Question: In one sentence, what is this figure communicating?
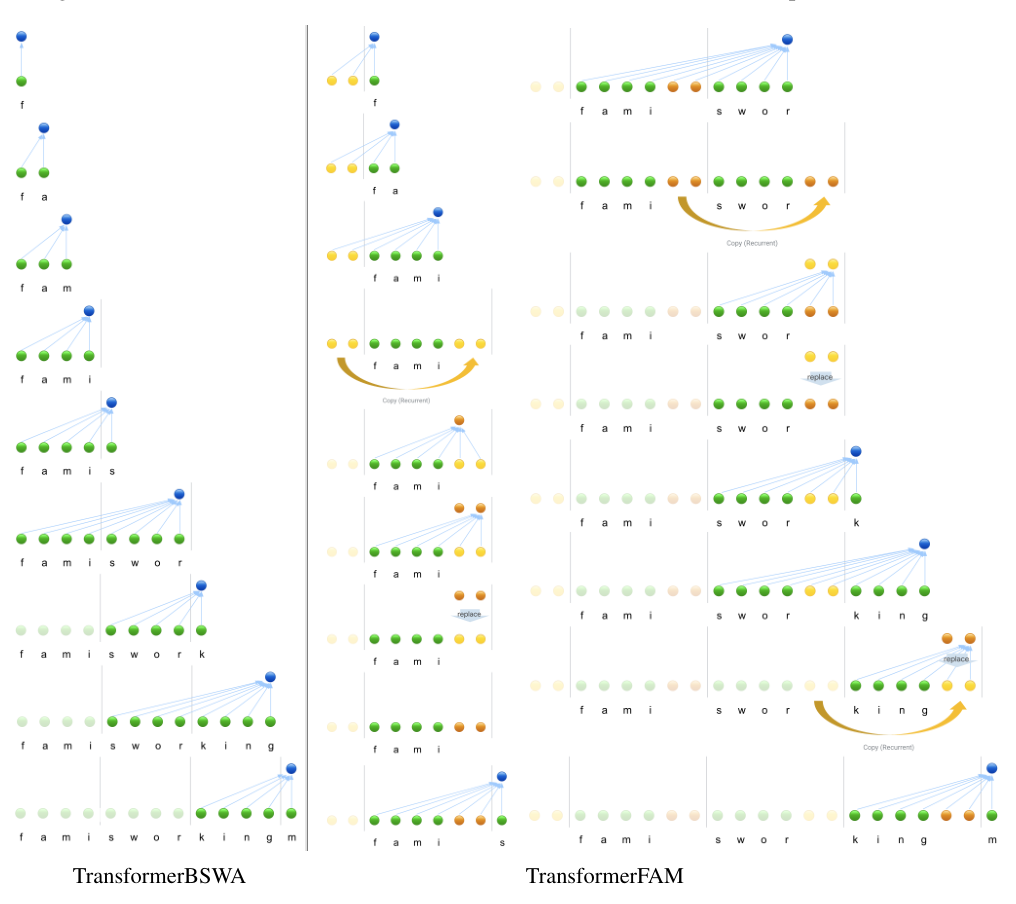
Answer: Visualization of self-attention during inference over time. (A) Self-attention pattern of TransformerBSWA layer with memory segment size of 1. (B) Self-attention pattern with FAM added.